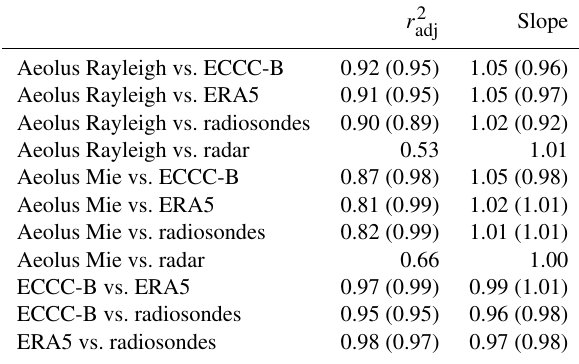
Table 1. Information on the adjusted r -squared and slope of the fitted line from Figs. 4 and 5 as well as the comparisons between ECCC-B, ERA5, and radiosondes at Iqaluit, with values for White- horse shown in